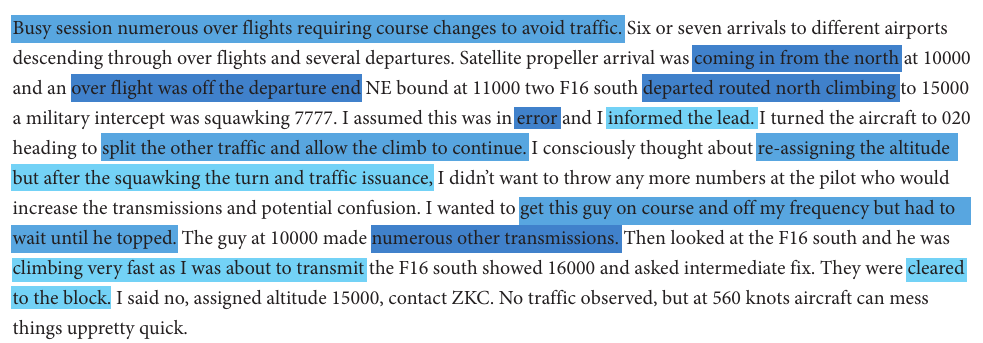
Figure 5: Example of narrative texts that have been processed by our model. With the attention mechanism application, the potential essential sentences or words are highlighted, and they are more comfortable for human experts to